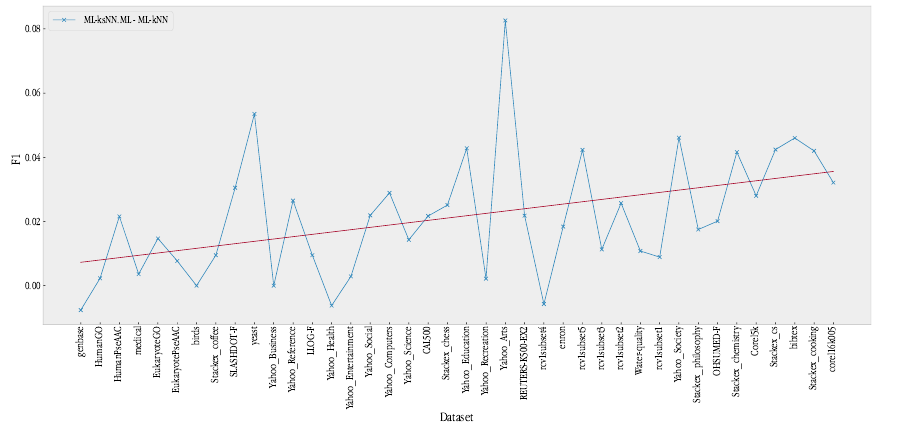
Figure 6. Difference in F1 metric between ML-k’sNN.ML and ML-kNN sorted by increasing dataset diversity. A linear regression of the difference in terms of the F1 metric is plotted in red